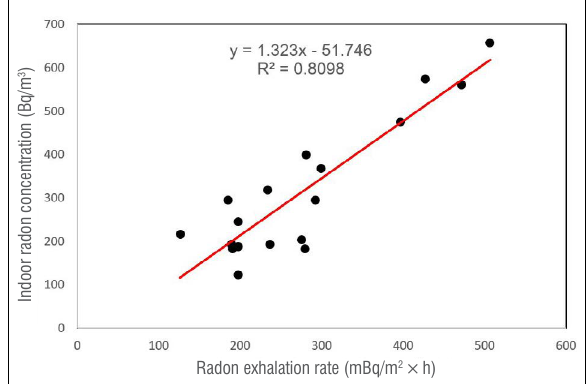
Figure 2: Indoor radon concentration as a function of radon exhalation rate measured from the Himachal Pradesh region. This relationship was then applied to radon exhalation rates of the Tusham Ring Complex 13 and the indoor radon concentrations were estimated for the Complex. The estimated indoor radon concentrations were plotted against measured uranium concentrations in the granitic soil and rock of the Tusham Ring Complex and a relationship between these parameters was extracted (Figure 3a). The uranium concentrations in this study were determined by applying the fission track registration technique to soil samples. 14 The extracted relationships between indoor radon concentrations and uranium concentrations from the Himachal Pradesh and Tusham Ring Complex were compared with radon build-up calculations that were done on the radon exhalation rates of the Tusham Ring Complex. The radon exhalation rate and the uranium concentrations of rock and soil were measured in the Tusham Ring Complex by Singh et al. 13 The radon exhalation rates and the uranium concentrations of soil samples were determined using the can 15 and fission track registration techniques, respectively. These measured radon exhalation rates were used to estimate indoor radon concentrations through the same method that was applied by Al-Jarallah 16 . A cuboid volume (3 m x 3 m x 2 m) was used as standard for the estimation. The estimated indoor radon concentrations were then plotted as a function of the uranium concentrations and a linear relationship was extracted (Figure 3b). This relationship compared reasonably well with the one that was extracted from the Himachal Pradesh measurements.